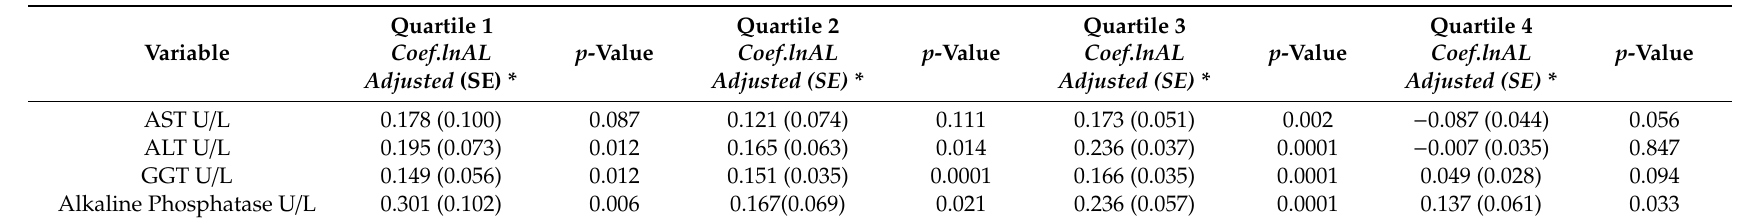
Table 2. Simple linear regression—relationship of allostatic load AL with hepatic-markers in Quartiles of lead